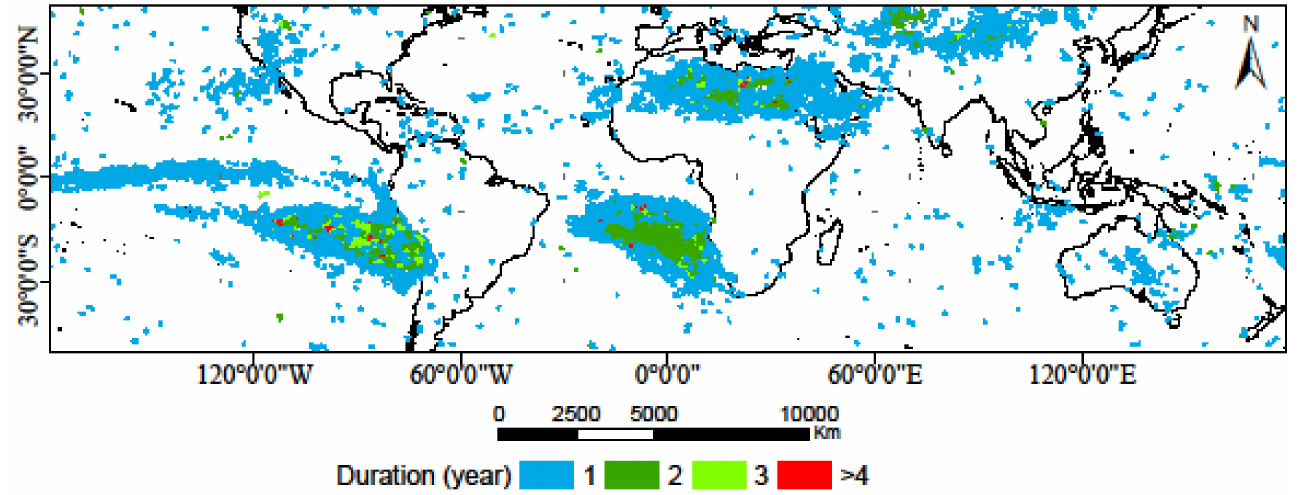
Figure 6. Duration (year) of the abrupt and non-abrupt changes in the global precipitation time series